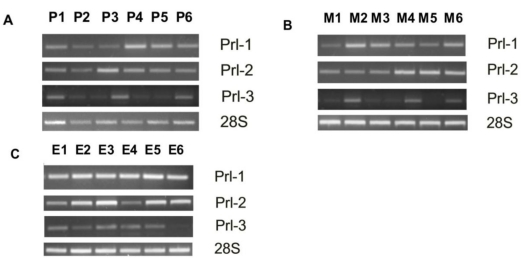
PRL expression at different anatomic sites in ovarian carcinoma (OC). (A–C) Representative gels showing PRL-1, PRL-2 and PRL-3 mRNA expression by RT-PCR; (D) PRL-3 protein expression by Western blotting; P = primary carcinoma, M = solid metastasis, E = effusion; (E) Differential expression of PRL-1 mRNA in OC effusions compared to primary carcinomas and solid metastases (Kruskal-Wallis H Test, p < 0.001); (F) Differential expression of PRL-1 and PRL-2 mRNA in pleural compared to peritoneal effusions (Mann-Whitney U Test, p = 0.001).